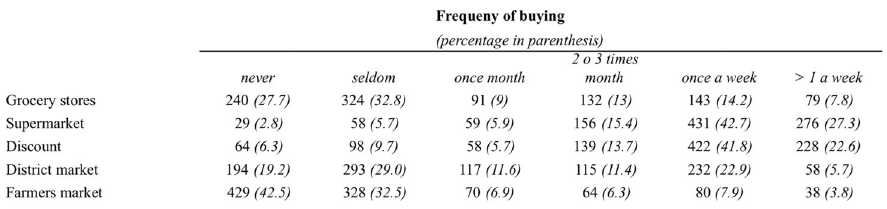
Table 3 Percentages of the frequency of buying food at different sales